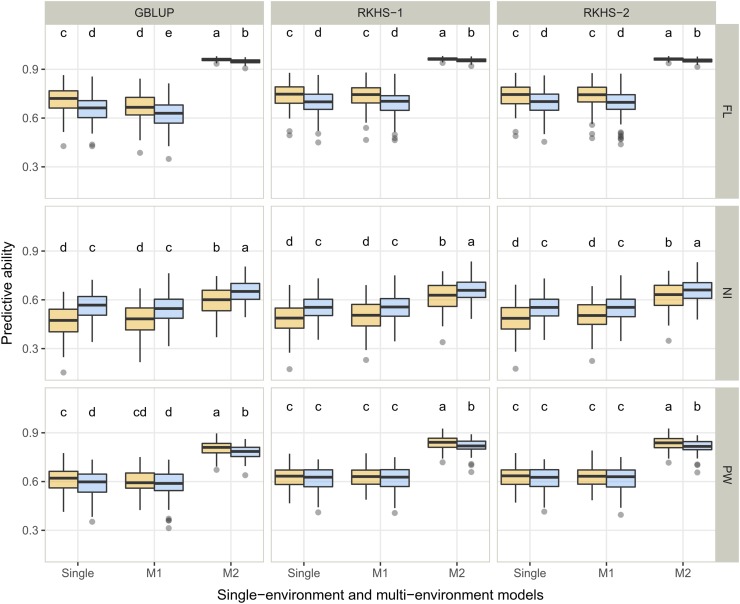
Single environment and multi-environment (M1 and M2) predictive ability in cross validation experiments in the reference population obtained with three statistical models (GBLUP, RKHS-1, RKHS-2). Continuous flooding and alternate wetting and drying water management conditions are in blue and orange, respectively. The three studied traits are presented: days to flowering (FL), nitrogen balance index (NI) and panicle weight (PW). The letters in each panel represent the results of Tukey’s HSD comparison of means and apply to each panel independently. The means differ significantly (p-value < 0·05) if two boxplots have no letter in common.